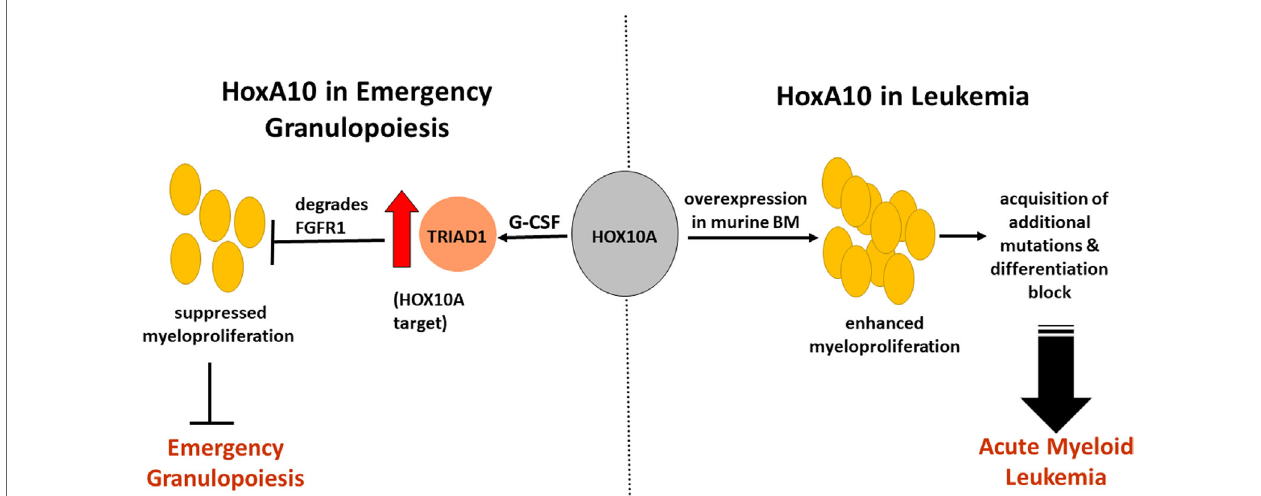
FiGURe 1 | Impact of HOXA10 on acute myeloid leukemia (AML) development and emergency granulopoiesis (EG) through regulation of myelopoiesis. HOXA10 overexpression in murine bone marrow leads to enhanced myeloproliferation, which progresses into AML through acquisition of additional mutations and differentiation block. HOXA10 effects EG by regulating the gene ARIH2 , which encodes TRIAD1, a ubiquitin ligase. In vitro stimulation of myeloid progenitors with granulocyte colony stimulating factor (G-CSF) showed HOXA10-dependent increase in TRIAD1 expression. Increased TRIAD1 expression degrades fibroblast growth factor receptor-1 (FGFR1), reduces the effect of FGF2, and terminates the effect of FGF2 on myeloid progenitor expansion. As G-CSF is the main mediator of EG, these processes result in termination of EG with HOXA10 being the prime regulator. Suppressed EG response during infections in leukemic conditions may serve as one of the causes of